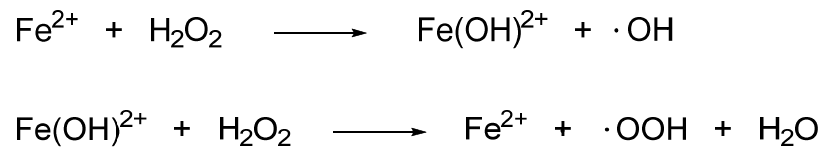
Figure 2. Decomposition of IPETC in FeCl 3 /H 2 O 2 system. Numbers in the legend represent conc. of H 2 O 2 and Fe in ppm. 2.3. Reaction with Sodium Hypochlorite An alternative method for the removal of organic compounds from wastewater is treatment with strong oxidants, e.g., sodium or calcium hypochlorite [33,34]. Sulfur compounds are susceptible to oxidation, yielding various oxidation products. Sulfur atom is usually transformed to sulfate in the final stage [33]. Reactions of IPETC with NaOCl in phosphate buffer at pH 7 with various amounts of hypochlorite were performed. The reaction is fast, IPETC reacts within minutes. With small amounts of hypochlorite, two products were detected, the principal one being O - isopropyl N -ethylcarbamate, 1 . When increasing the amounts of hypochlorite added, the